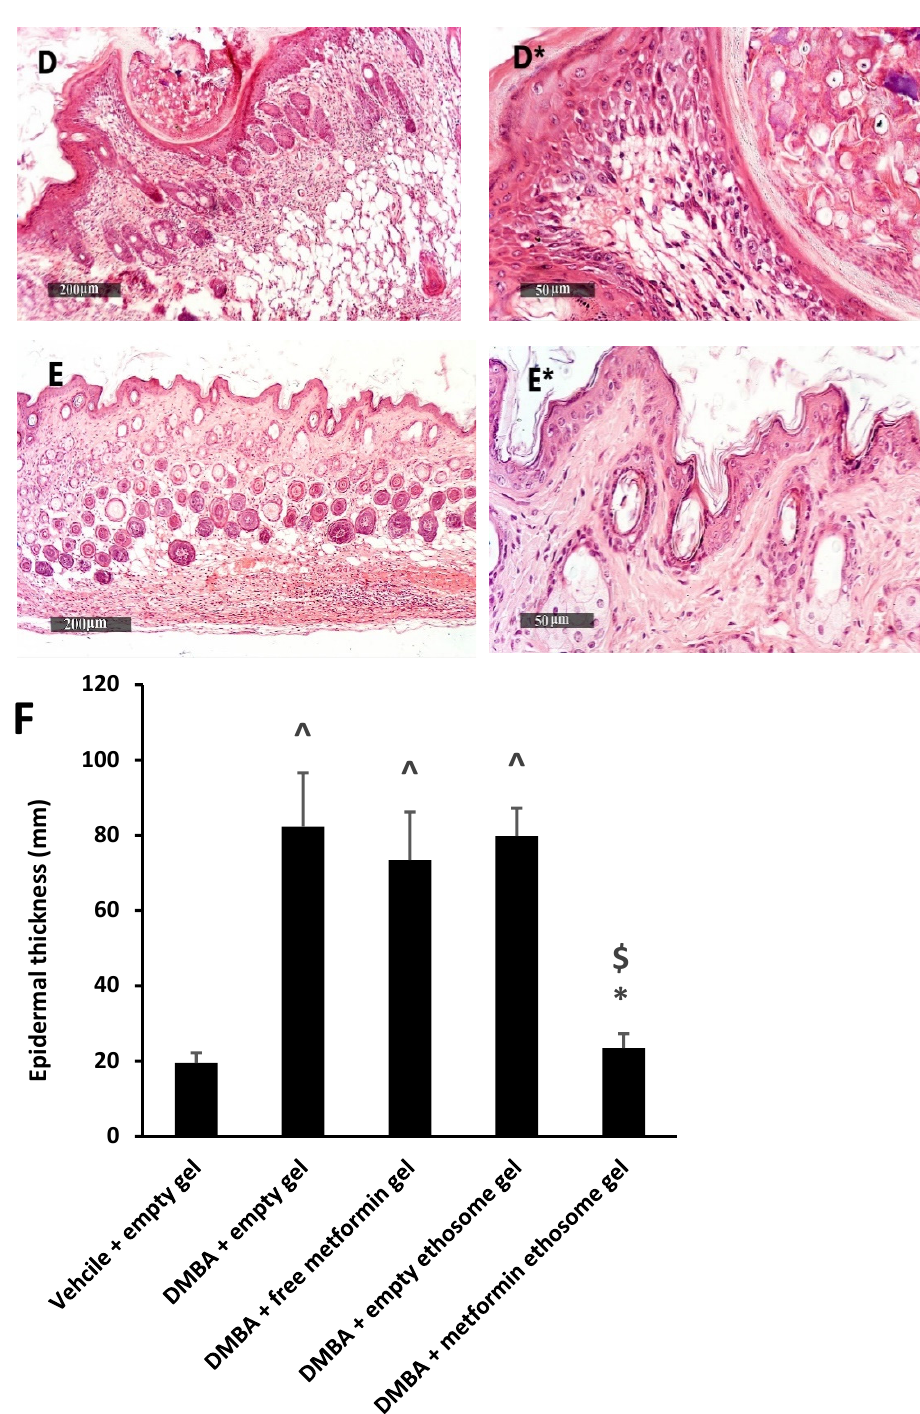
Figure 10. Histopathological picture of skin tissues stained with hematoxylin and eosin. ( A , A* ) Images revealed normal morphological features of mouse skin layers with an apparent intact thin epidermal layer with intact keratinocytes and an intact dermal layer with well-organized collagen fibres and hair follicles without abnormal inflammatory cells infiltrates, as well as an intact subcuta- neous tissue. ( B , B* ) Images for DMBA + empty gel, showing a circumscribed raised, folded mass with non-keratinized epidermal layers of hyperplasia with the adjacent ulcerated area covered with the scab of necrotic tissue depress. The underlying dermal layer showed severe diffuse inflammatory cell infiltrates from different populations accompanied with fibroblastic activation and few records of keratin cysts, as well as abundant records of congested blood vessels (BVs). ( C , C* ) Images from the DMBA+free metformin group showing focal areas of moderate hyperplasia of non-kerat- inized epidermal layers without ulcerated lesion records associated with focal subepidermal fibro- blastic activation with higher collagen fibres contents. The persistence of moderate-to-severe inflam- matory cell infiltrates was shown; however, a less intense density compared with the model samples was accompanied by abundant records of subepidermal and subcutaneous-congested BVs. ( D , D* ) Images for skin specimens from the DMBA+empty ethosome group showing a circumscribed, raised non-ulcerated mass of skin with moderate epidermal thickening and folding covered with a mass of necrotic tissue to depress with focal subepidermal hemorrhagic patches and mild records of in- filtrate of inflammatory cells, as well as fibroblastic activity with minimal records of congested sub- cutaneous BVs. ( E , E* ) Images for the DMBA+metformin-loaded ethosome group (optimal gel for- mula) showing obvious improvement of the histological organization epidermal/dermal layers with an almost apparent intact, mildly folded epidermal layer with apparent intact keratinocytes and an abundant mature collagen formation in a mildly thick dermal layer with minimal inflammatory cells infiltrates. However, there were also focal records of subcutaneous hemorrhagic patches with moderate inflammatory cell infiltrates, as well as congested and dilated BVs. ( F ) Epidermal thick- ness of the skin layers in all groups. Thicknesses of six regularly spaced skin parts were measured using ImageJ software (NIH, Maryland, MD, USA). The average of the measured parts was calcu- lated for every tissue specimen, and the mean of each group was then estimated. Data were the mean ± SD and analyzed using one-way ANOVA, while the pairwise comparison was estimated by Bonferroni’s test at p < 0.05. ^: versus the vehicle+empty gel group, *: versus the DMBA+empty gel group, &: versus DMBA+free metformin gel. $: versus DMBA+empty ethosome gel, scale bar = 200 µm (left column) and scale bar = 50 µm (right column).